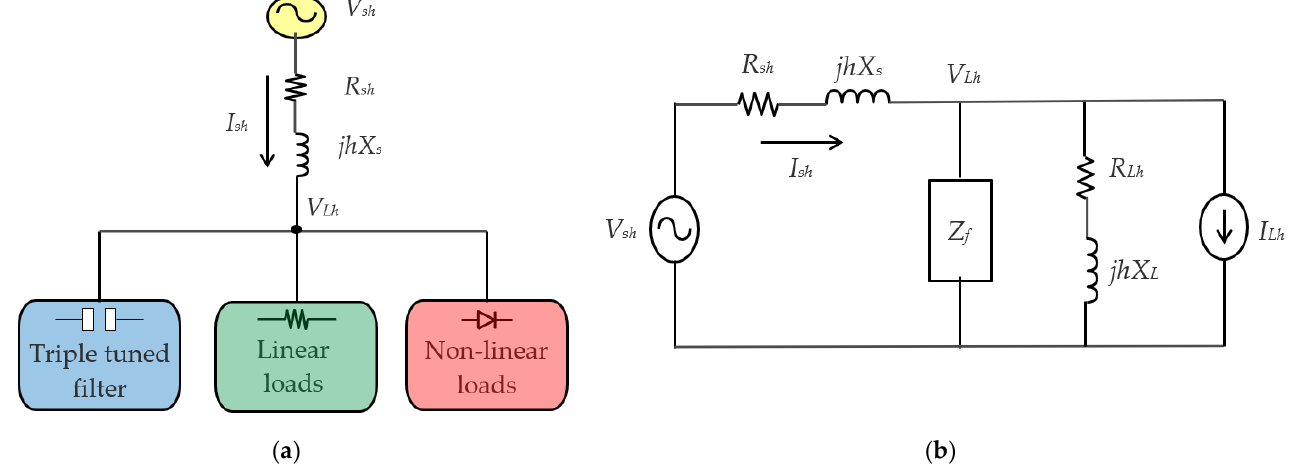
Figure 5. The system under study: ( a ) Its single line diagram; ( b ) Its per-phase equivalent circuit. In the equivalent circuit, the impedance of the linear load, supply line, and filter are expressed as the h th harmonic impedances denoted Z Sh , Z Lh and Z Fh , respectively, thus: